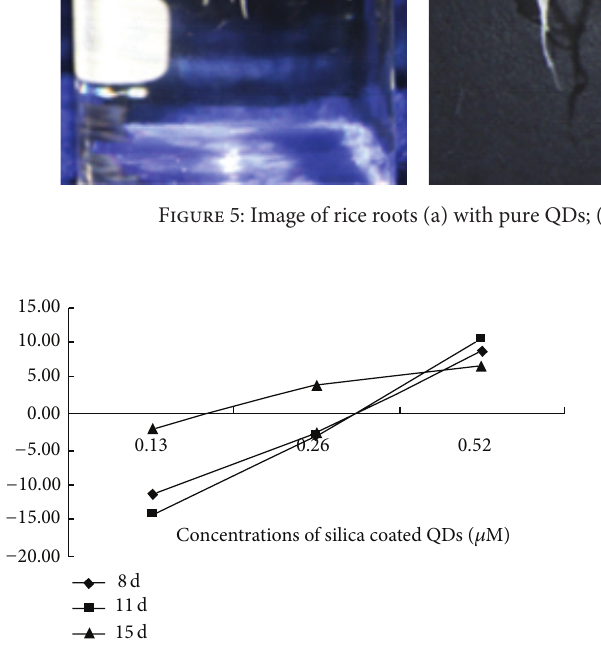
Figure 6: Effects of silica coated QDs at different concentrations on rice root